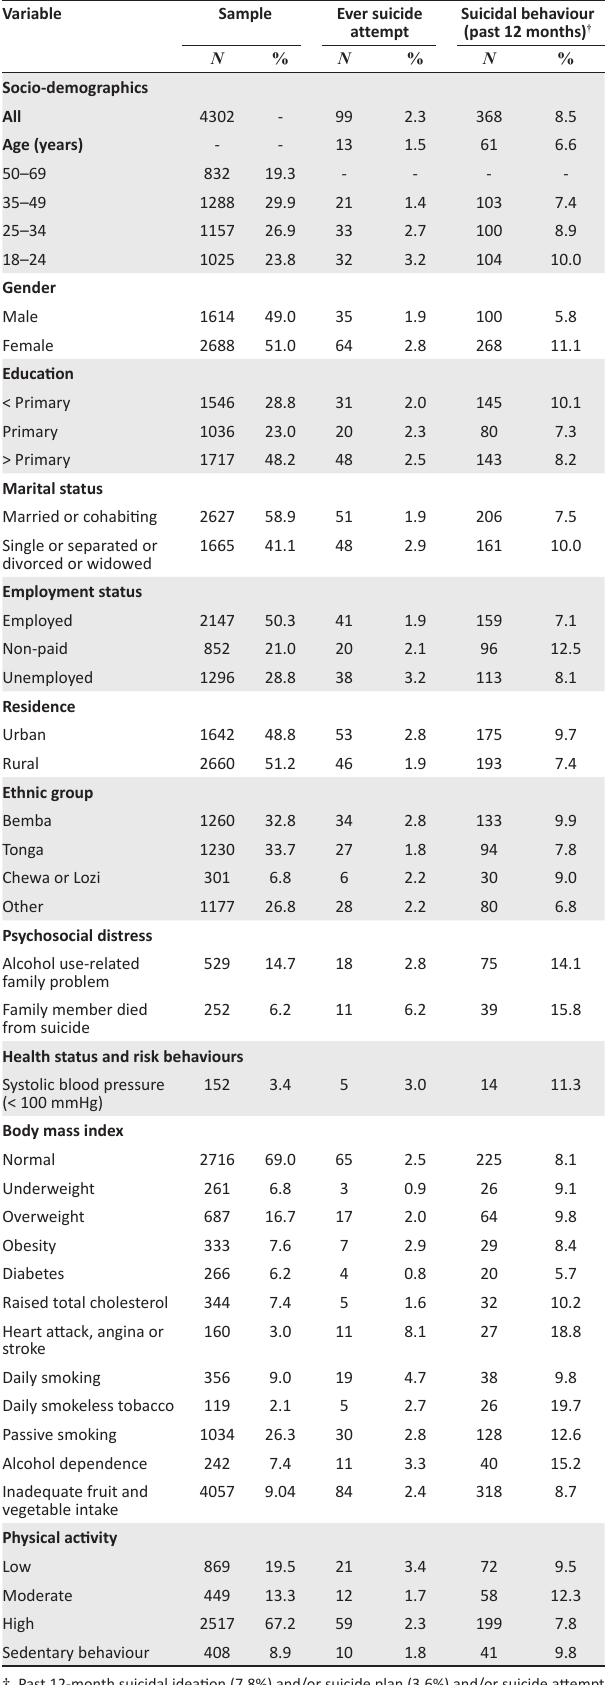
TABLE 1: Sample and suicidal behaviour characteristics among 18–69-year-old persons in Zambia. Variable